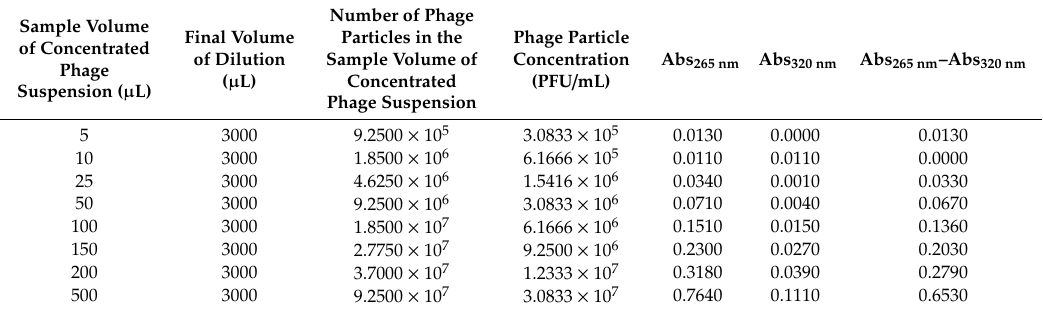
Table 2. Data utilized to prepare a calibration curve aiming at determining the molar extinction coe ffi cient of phage φ 6 (whole) particles.